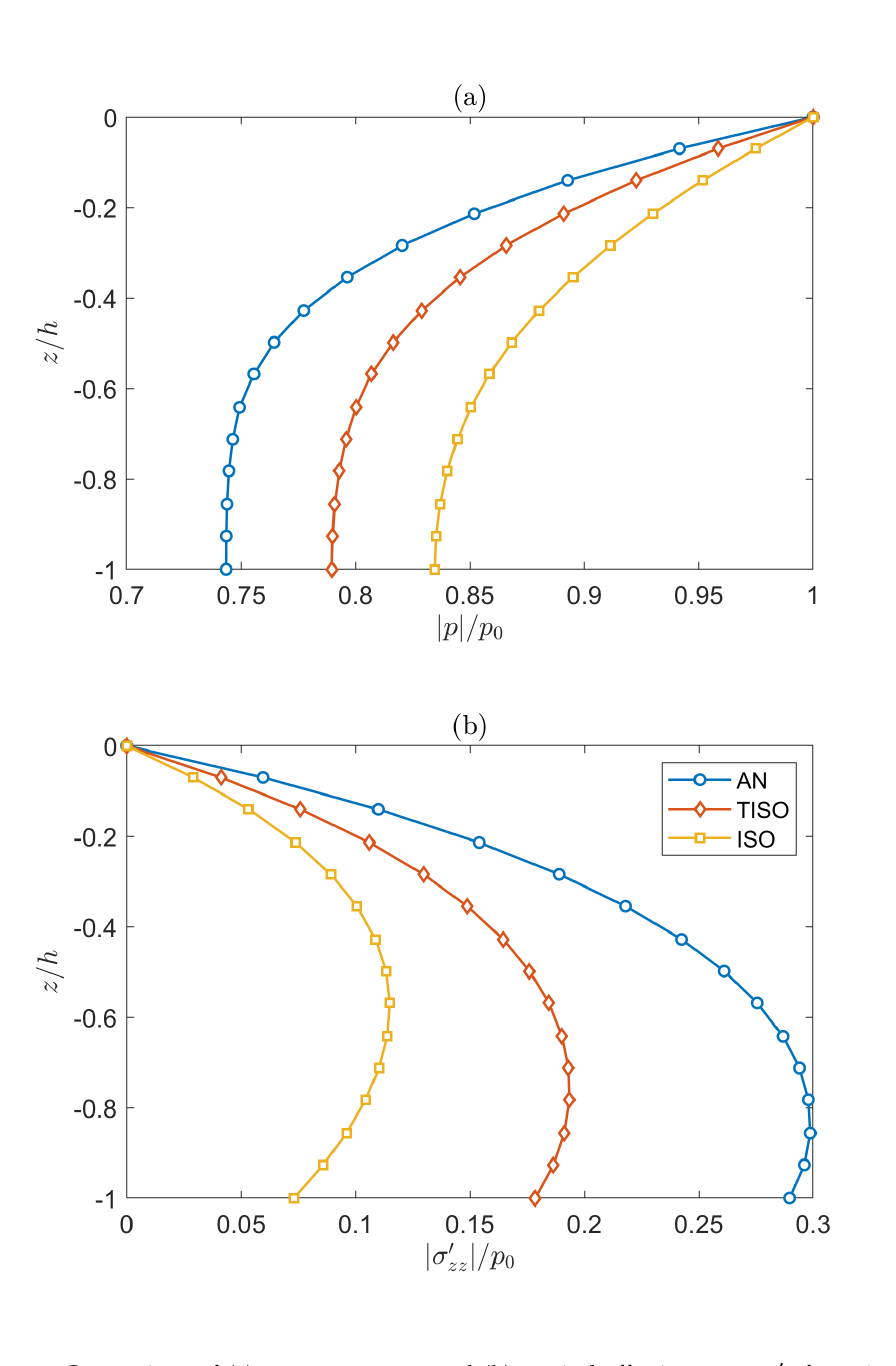
Figure 5. Comparison of ( a ) pore pressure p and ( b ) vertical effective stress σ (cid:48) zz for anisotropic (AN), transverse isotropic (TISO), and isotropic (ISO) permeabilities (AN, TISO, and ISO correspond respectively to Cases 2, 8, and